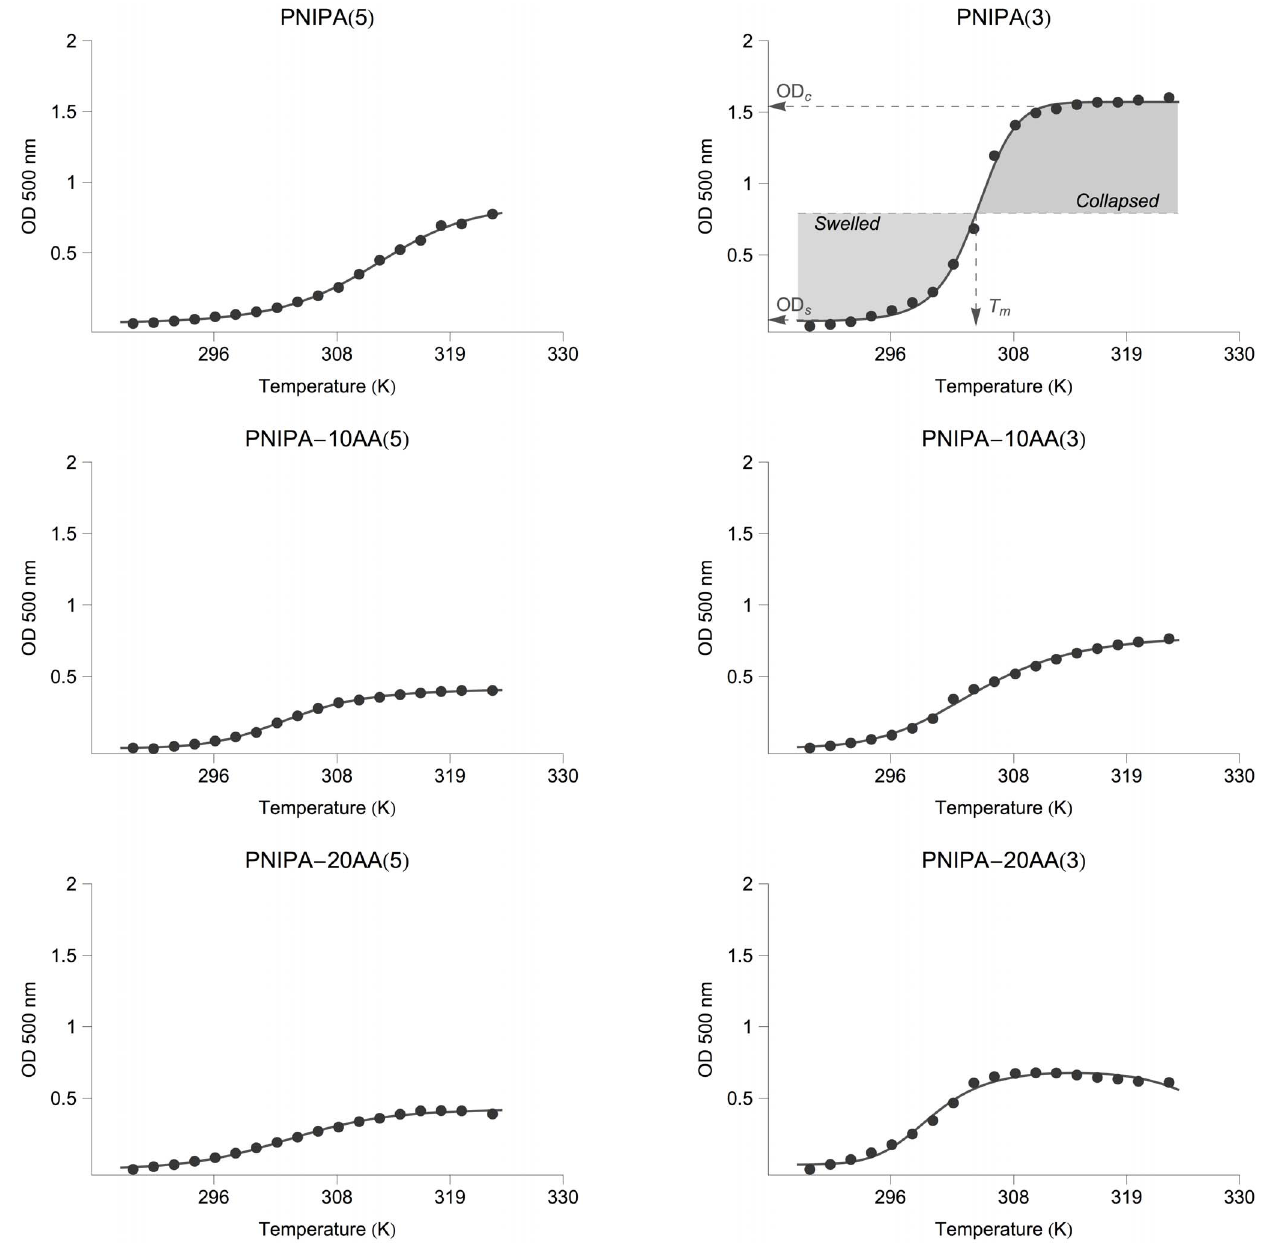
Figure 4. Optical density (OD) variation of PNIPA/AA nanohydrogel as a function of temperature (K). Nanohydrogels synthesized with 3% and 5% of cross-linking degree (CL) were previously swelled in distilled water (12.5 mg mL 2 1 ) at 25 u C. The lines are the fitting curves generated from Equation 13. The meaning of the most relevant parameters for defining a collapse curve of a PNIPA nanohydrogel exposed to increasing temperatures is graphically illustrated in the subfigure PNIPA(3): T m represents the lower critical solution temperature (LCST), OD s and OD c are the characteristic optical density values in the swelled state and the collapsed state, respectively.’’